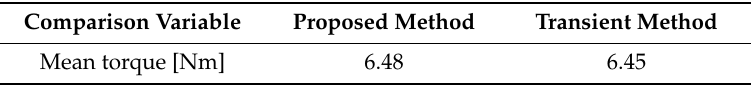
Table 5. Comparison between the